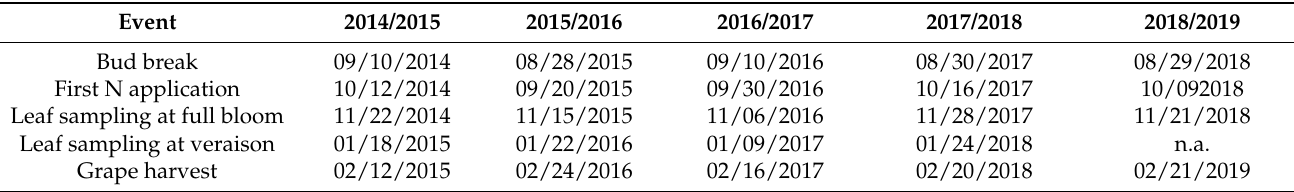
Table 5. The dates (month/day/year) of events in the experimental